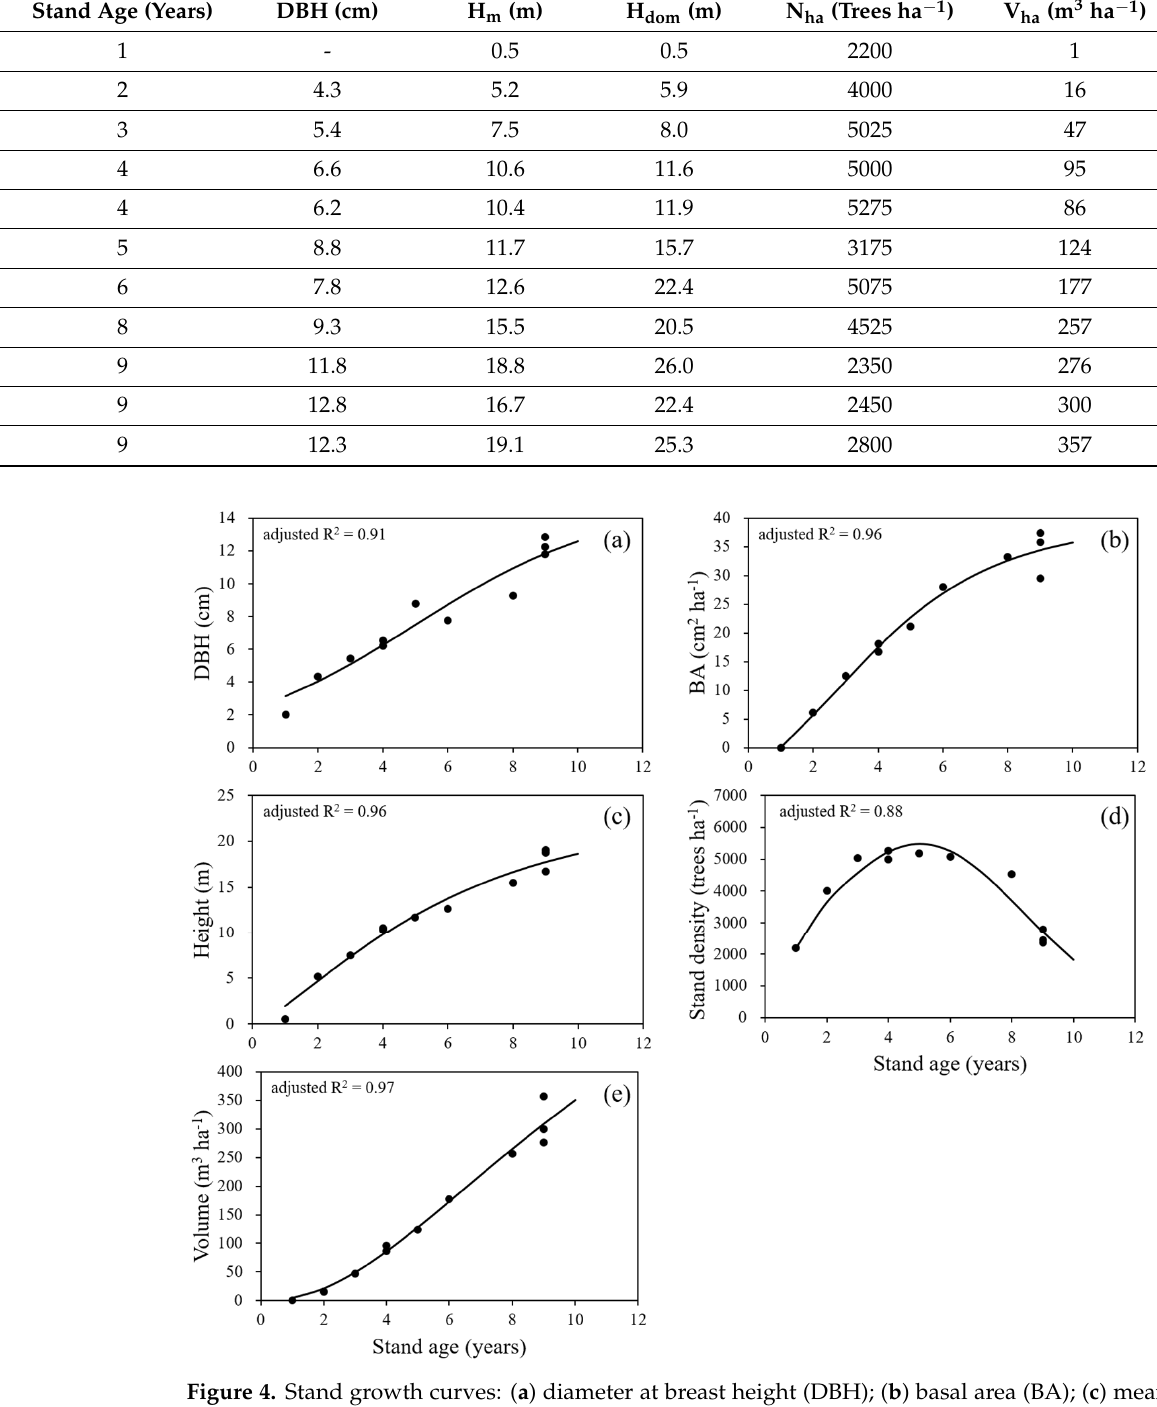
Figure 4. Stand growth curves: ( a ) diameter at breast height (DBH); ( b ) basal area (BA); ( c ) mean height (H m ); ( d ) stand density; and ( e ) stand volume, over stand age for Acacia hybrid plantations in southern Vietnam.